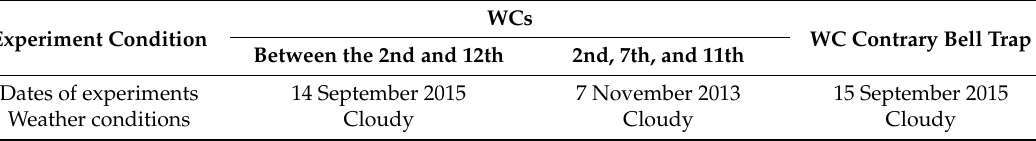
Table 1. Dates of experiments and weather conditions.